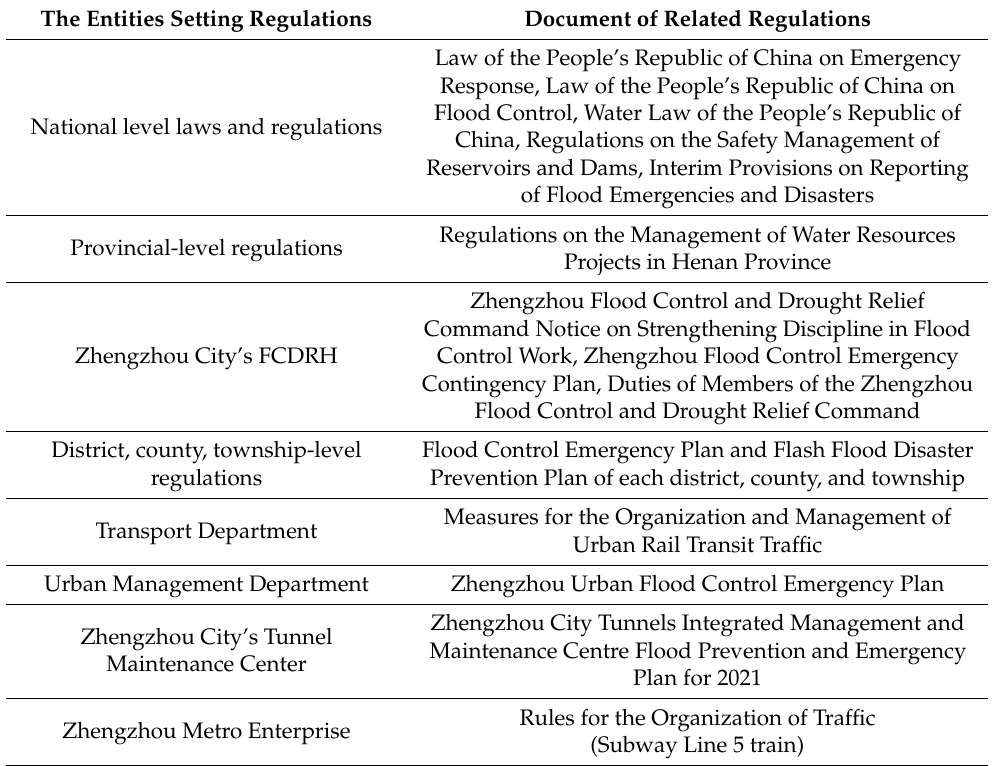
Table 1. Related Emergency Regulations and Its Formulation Subject in “7-20” Extreme Rainfall Event in Zhengzhou, Henan